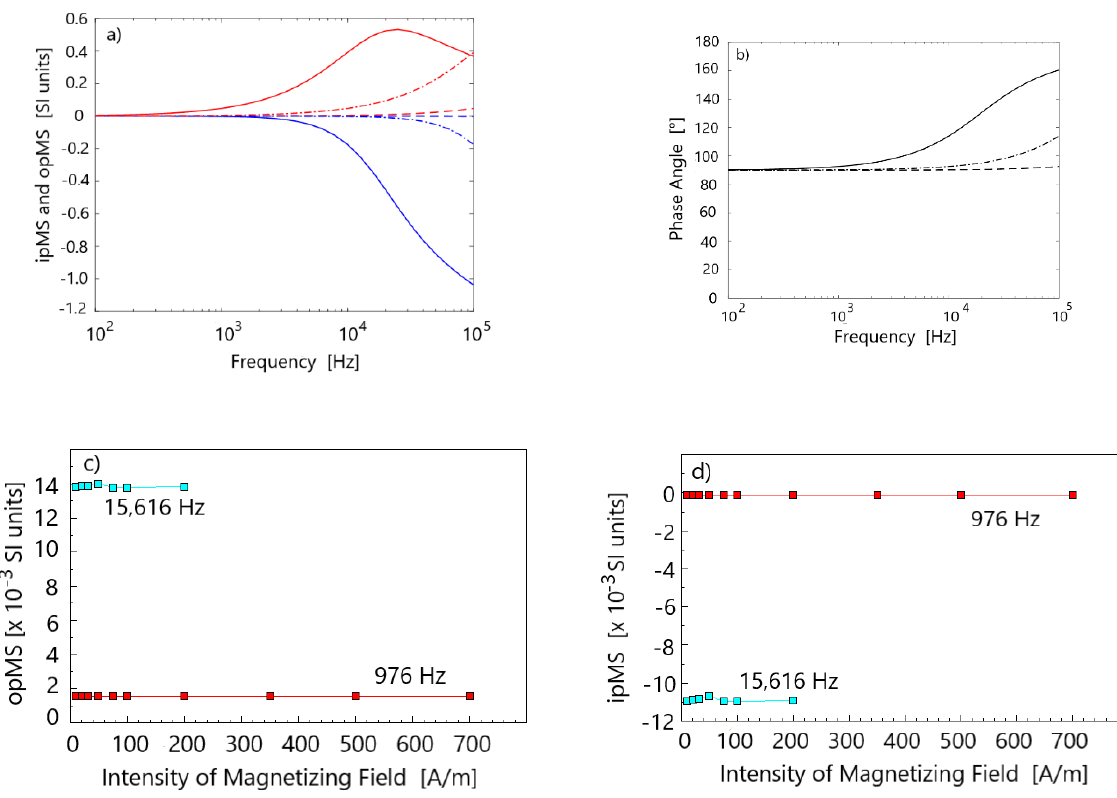
Figure 6. ( a ) Model of the ipMS ( κ′ , in blue) and opMS ( κ″ , in red) variation of a sphere with zero DC susceptibility according to operating frequency, electrical conductivity ( σ ), and sphere diameter ( r ); ( b ) phase angle in the same sphere. Legend: solid lines r = 1 mm, σ = 6 × 10 7 S/m, dash lines r = 0.1 mm, σ = 6 × 10 7 S/m, dash-and-dot lines r = 1 mm, σ = 6 × 10 6 S/m. Calculated using Equation (7). ( c ) opMS vs. field and frequency and ( d ) ipMS vs. field and frequency in copper (for more details see [25]); opMS and ipMS are in terms of total susceptibility (not normalized against volume).